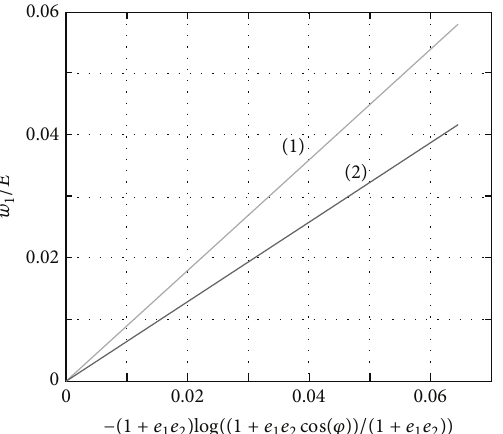
Figure 16: Dependence of the elastic energy density (normalized by the elastic modulus) on the eccentricity of ellipsoids 𝑒 1 , 𝑒 2 and the relative position of major axles 𝜑 . (1) Hooke model; (2) Mooney-Rivlin